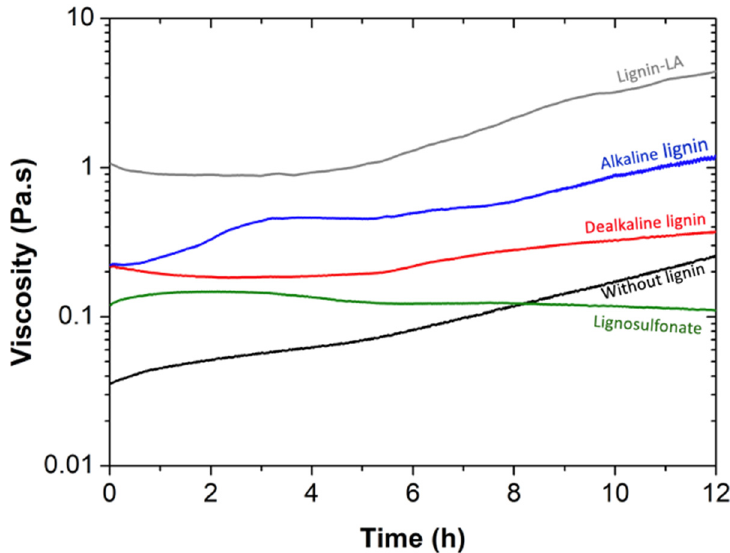
Figure 1. Viscosity as a function of time for resin without lignin (black), and BPF resins with 30 wt% dealkaline lignin (red), alkaline lignin (blue), lignosulfonate (green), and lignin-LA (gray). All the resins were produced using 2 wt% NaOH. The shear stress and temperature were kept constant at 10 Pa and 20 ◦ C,